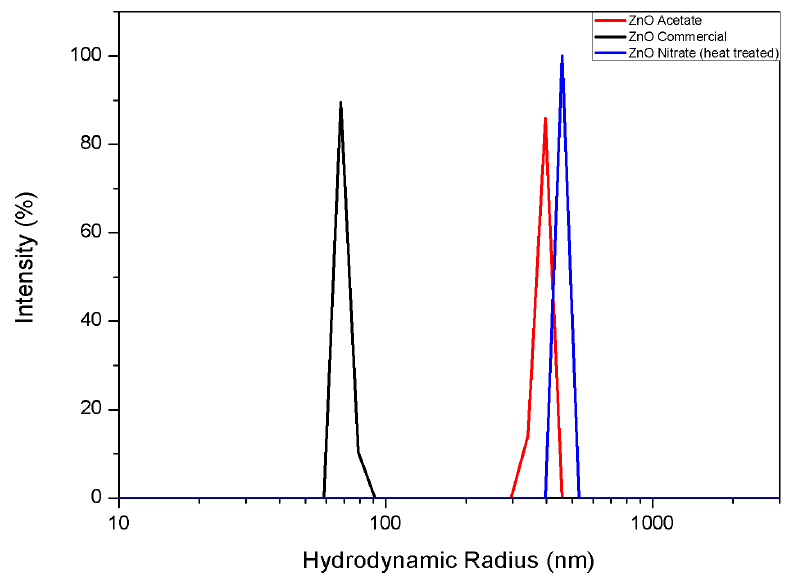
Figure 2. DLS results on the hydrodynamic radius of ZnO samples: ZnO Acetate route (red), ZnO commercial (black), and ZnO Nitrate route (blue).